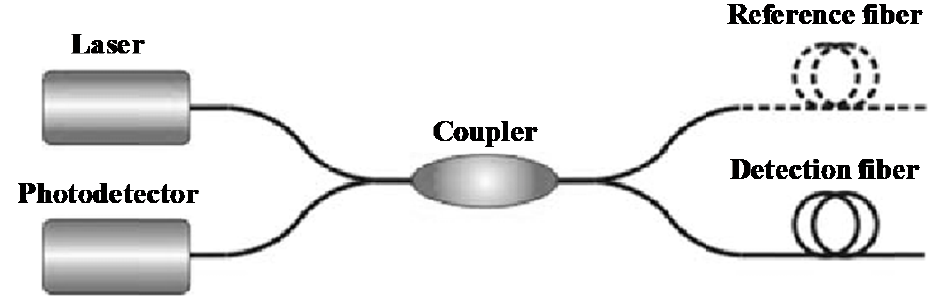
Figure 12. Schematic of the MSI.